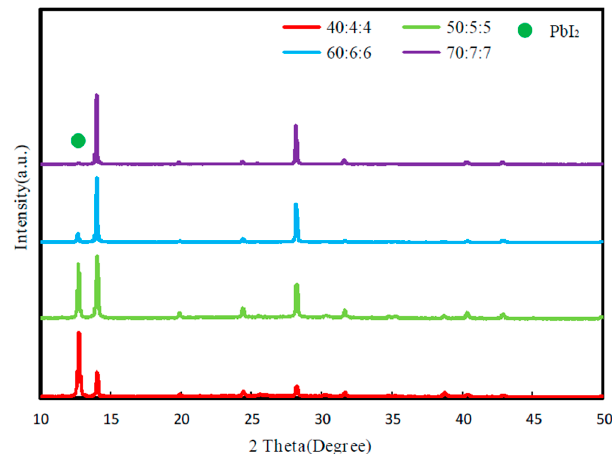
Figure 2. Normalized XRD patterns of perovskite layers prepared with mixed formamidine methylamine halide precursor solutions at different concentrations.